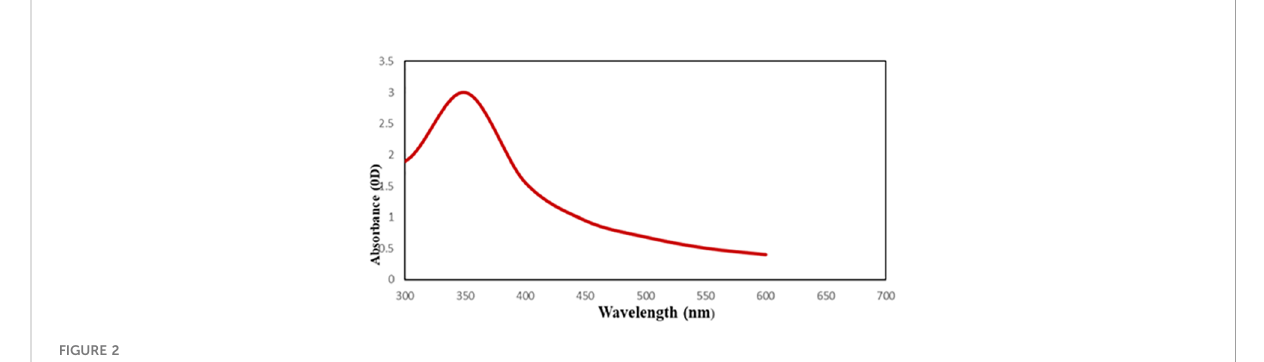
FIGURE 2 UV-Visible spectrum of